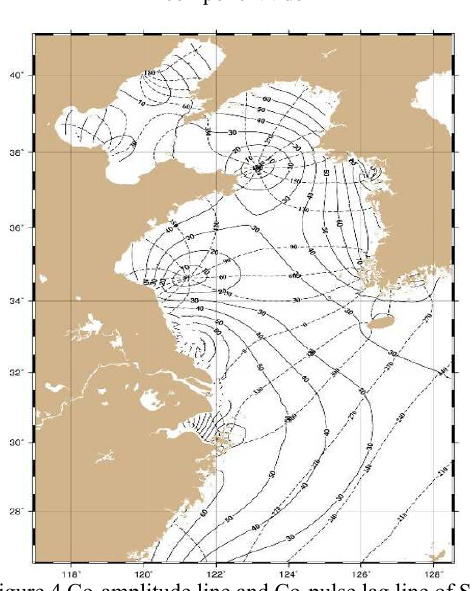
Figure.4 Co-amplitude line and Co-pulse lag line of S2 component tide